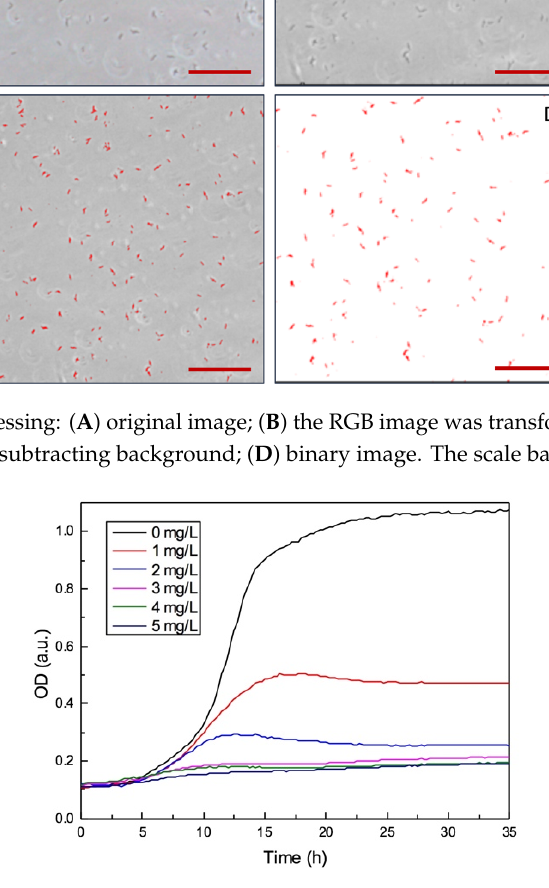
Figure A2. The growth curve of bacteria in 96 well-plate. E. coli were inhibited by 1, 2, 3, 4, 5 mg/L amoxicillin.